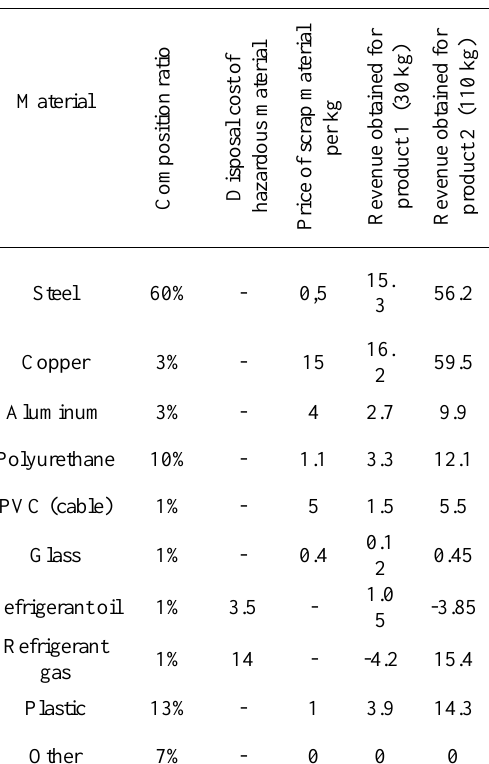
Table 1. Material composition and scrap value prices for Type-1 and